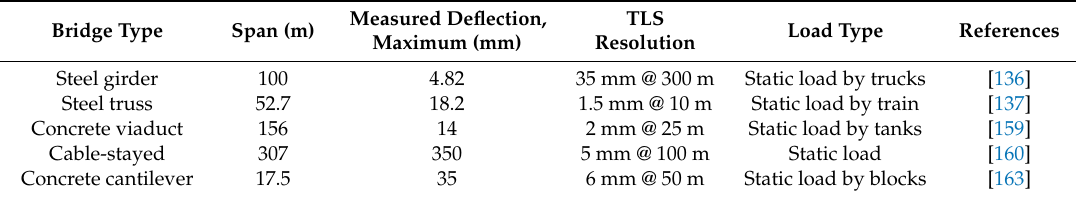
Table 8. Examples of deflection measurement using TLS for di ff erent types of